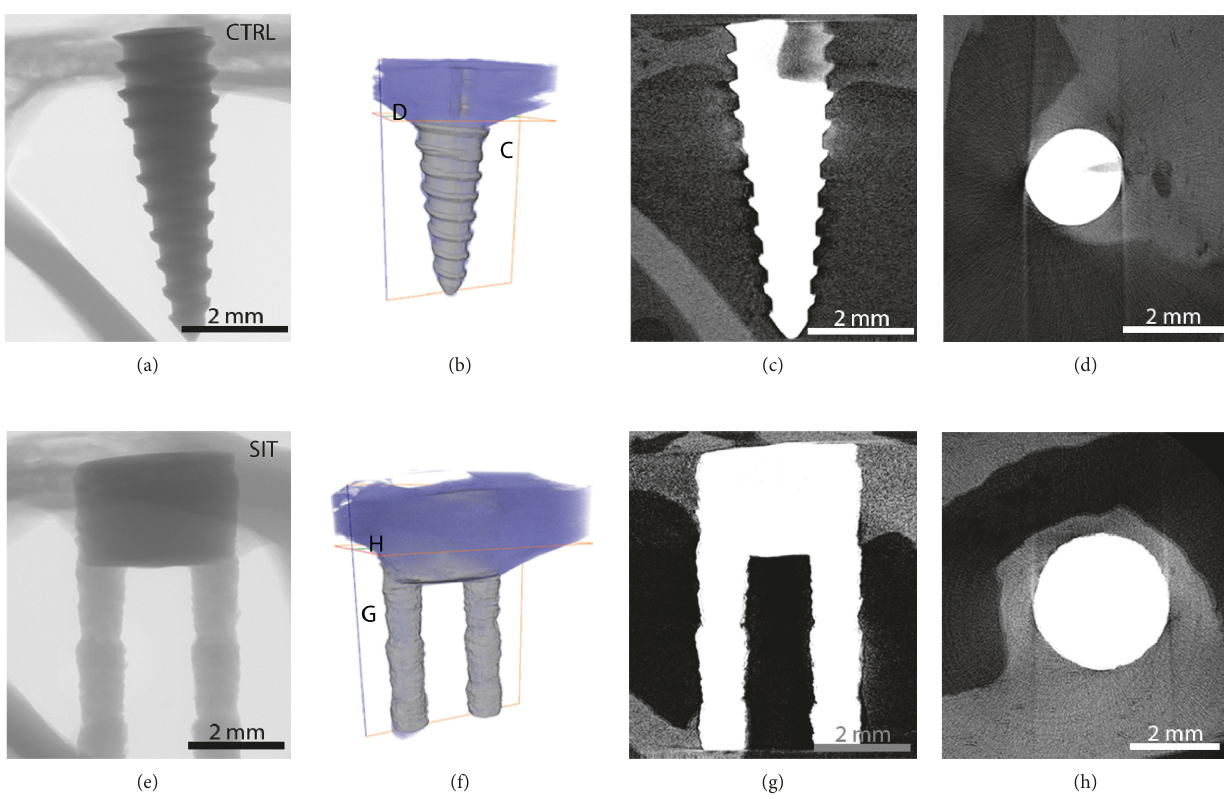
Figure 6: Micro-CTanalysis following 12-week implantation of CTRL (left column) and SIT (right column) implants. (a, e) Radiographs of each implant. (b, f) 3D visualization of the implant and bone (purple) with orthogonal planes labelled, (c, d, g, h) corresponding orthoslices from (b, f) where the new bone has matured and is of equal intensity to the preexisting bone. Both implants showed bone conduction down the implants from the cortical bone crest; however, bone growth between the stems was not noted in this particular specimen.